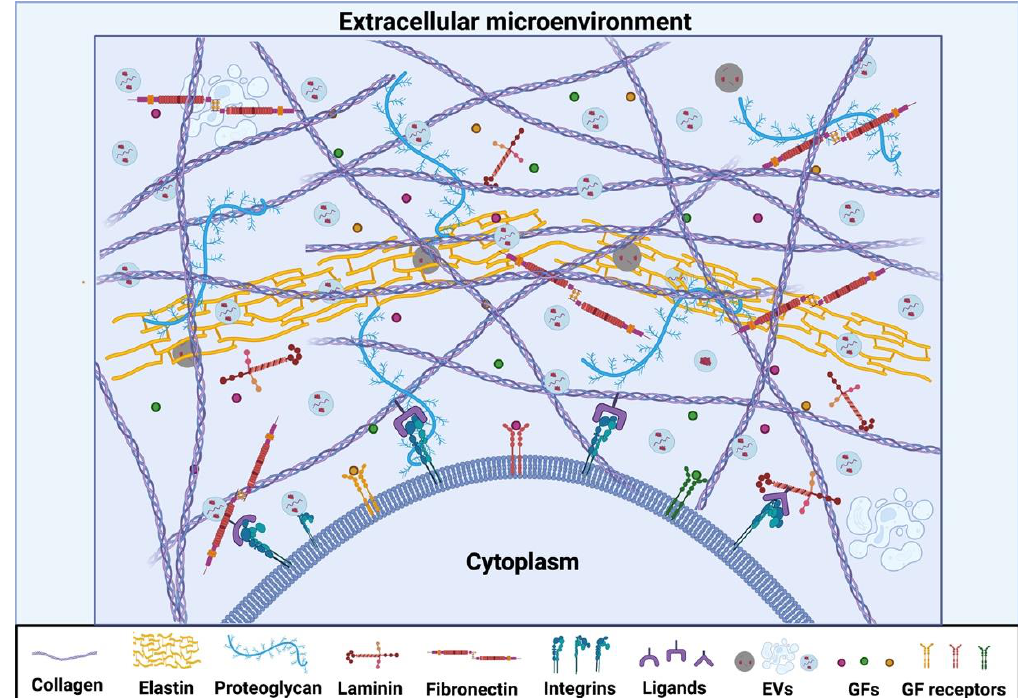
Figure 1. Schematic diagram of extracellular microenvironment.